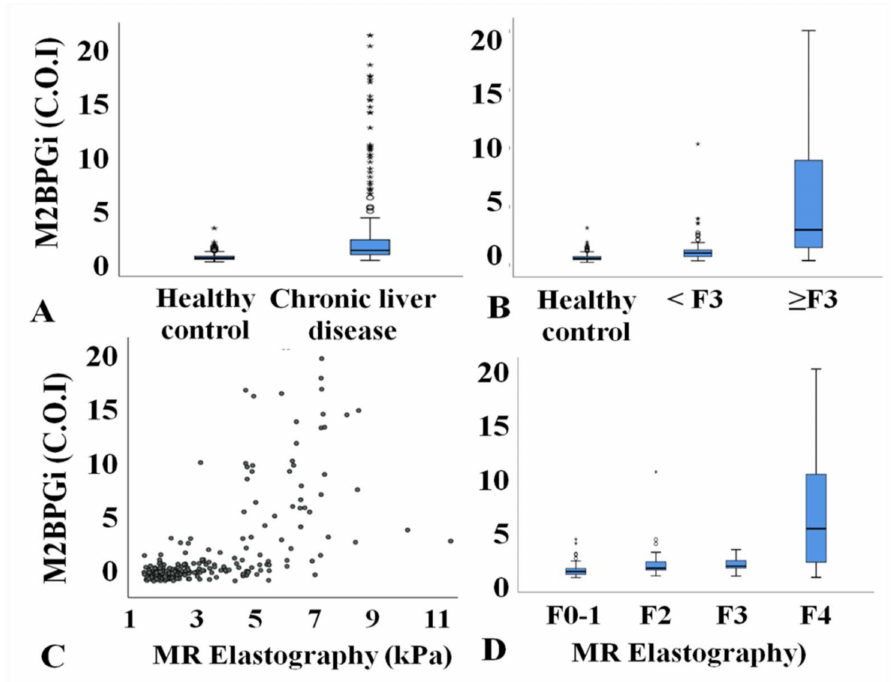
Figure 2. ( A ) Comparison of M2BPGi concentration between healthy subjects and those with chronic liver disease. ( B ) Comparison of M2BPGi concentration between healthy subjects, patients without advanced fibrosis ( < F3), and those with advanced liver fibrosis ( ≥ F3). ( C ) Correlation between M2BPGi concentration and magnetic resonance elastography (MRE). ( D ) M2BPGi concentration according to the severity of hepatic fibrosis based on